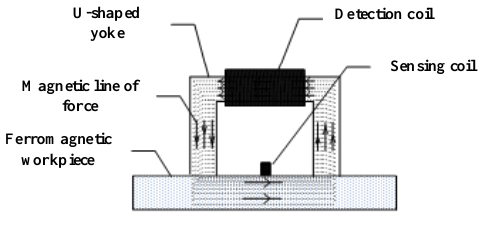
Figure 15. ACSM sensor.